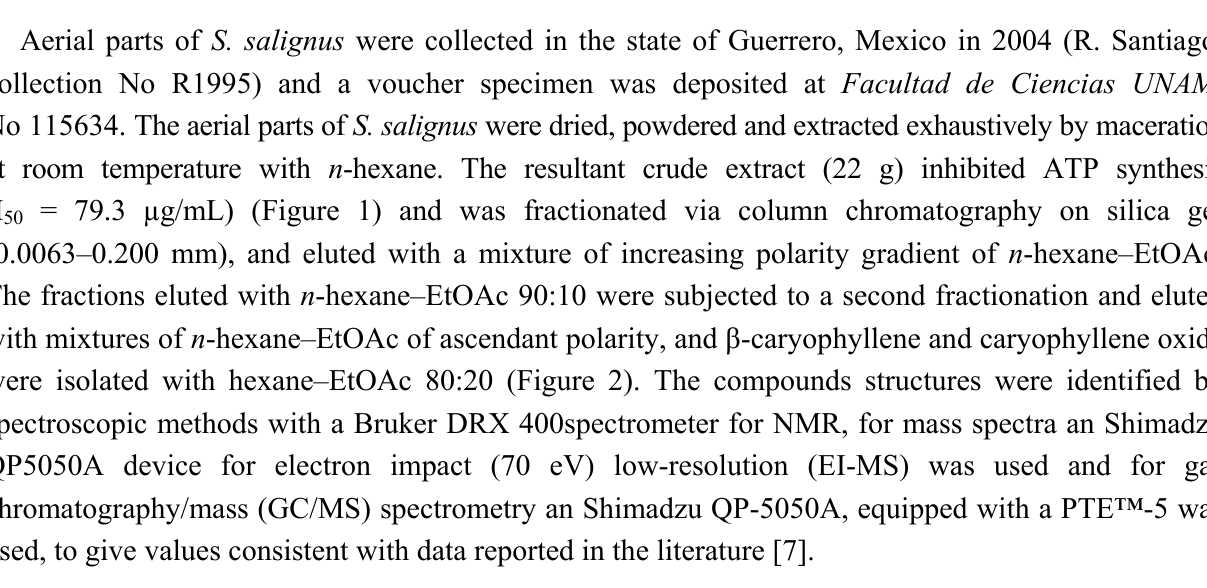
/ABS/(RC) ] × 100 in control C T